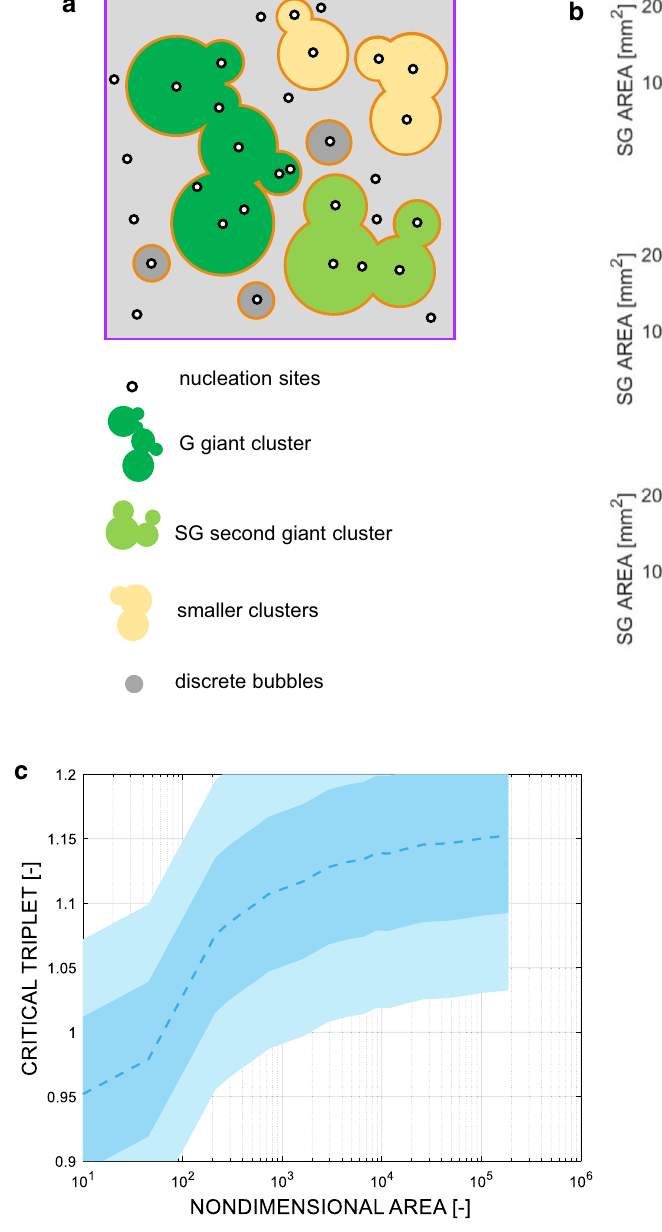
Fig. 8 | Results ofthe stochastic bubble interaction modeland control volume of hydrodynamic scaling analysis. a Example of the stochastic model output for oneiteration.OnecanrecognizethepresenceofagiantGbubblecluster,asecond giant SG bubble cluster, smaller bubble clusters and discrete, non-interacting bubbles. b Examplesofbivariatedistributionsofthegiantandsecondgiantbubble cluster areas (in 1/mm 4 ) for subcritical (top), critical (middle), and supercritical